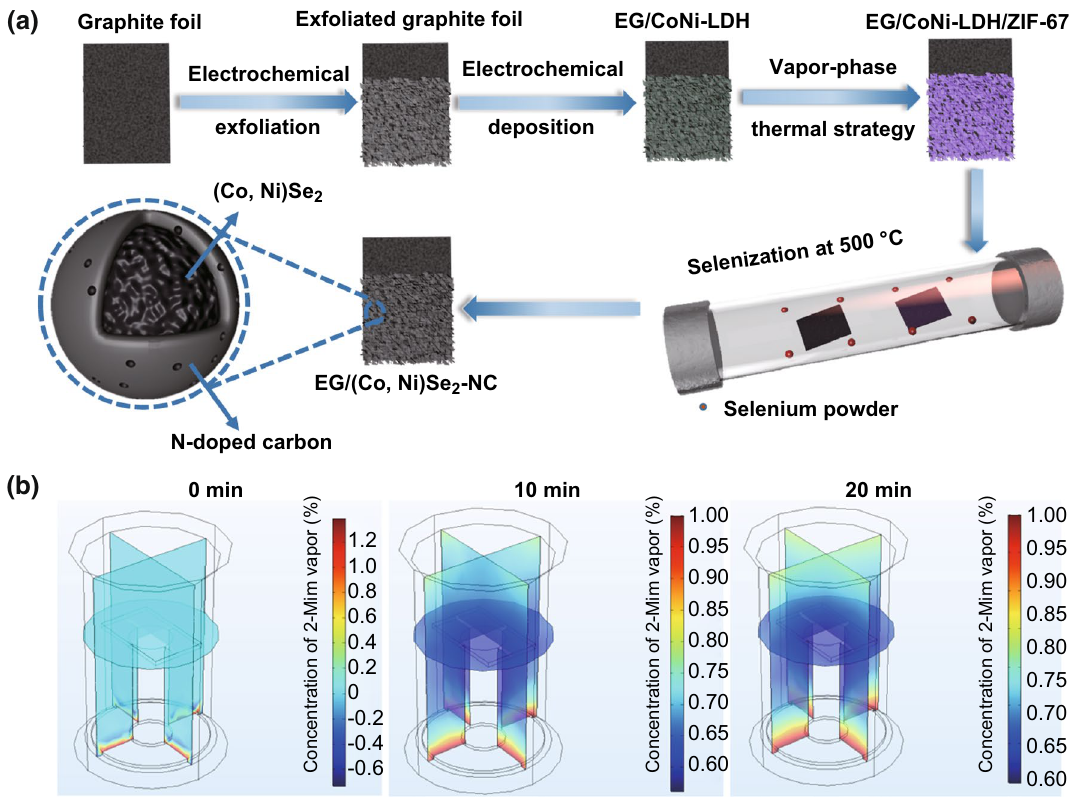
Fig. 1 a Synthetic scheme of EG/(Co, Ni)Se 2 –NC hybrid and b simulation of 2-MIm evaporation and diffusion